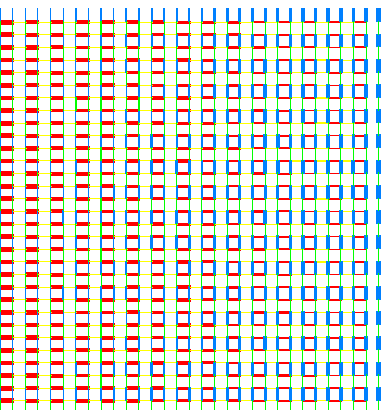
FIG. 23. Domain wall on a 32 × 32 lattice for a system with J ¼ 0 , Q ¼ 1 . The bonds are colored according to the convention in Fig. 3, and the line thickness represents the expectation value − h S · S . The left and right open boundaries are modified at i j i the Hamiltonian level to lock in VBS patterns differing in angle by Δ ϕ ¼ π = 2 . Note that a 2 × 2 plaquette with equal correlation on all edges seen in the middle of the system corresponds to the VBS angle ϕ ¼ π = 4